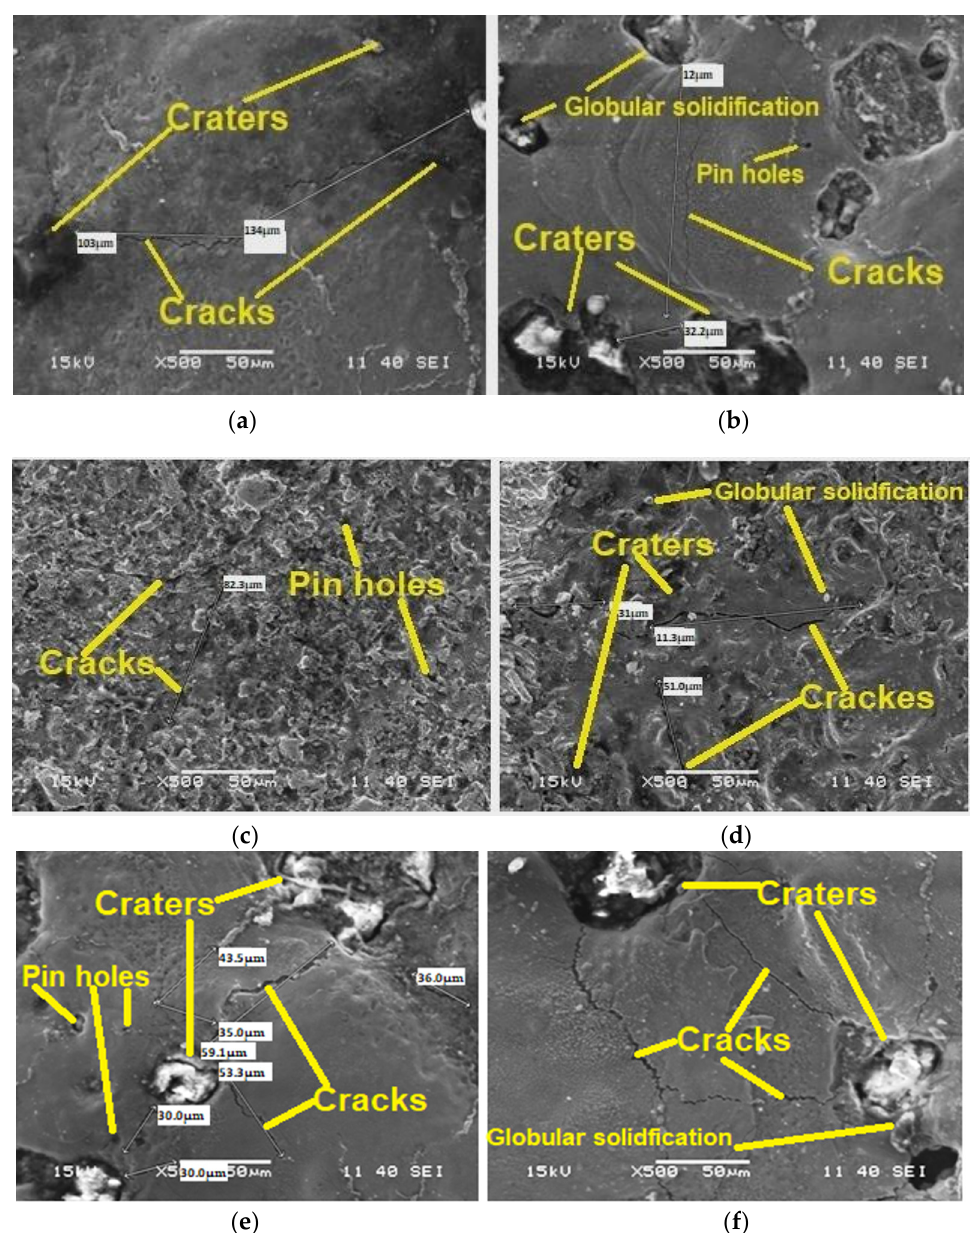
Figure 5. SEM micrograph of Ti-6Al-4V machined by Al, Brass and Cu electrode with 500× magni- fication. ( a ) Al tool tip with I = 5 A, T on = 1000 µs, T off = 2000 µs. ( b ) Al tool tip with I = 10 A, T on = 1000 µs, T off = 2000 µs. ( c ) Brass tool tip with I = 5 A, T on = 1000 µs, T off = 2000 µs. ( d ) Brass tool tip with I = 10 A, T on = 1000 µs, T off = 2000 µs. ( e ) Cu tool tip with I = 5 A, T on = 1000 µs, T off = 2000 µs. ( f ) Cu tool tip with I = 10 A, T on = 1000 µs, T off = 2000 µs.